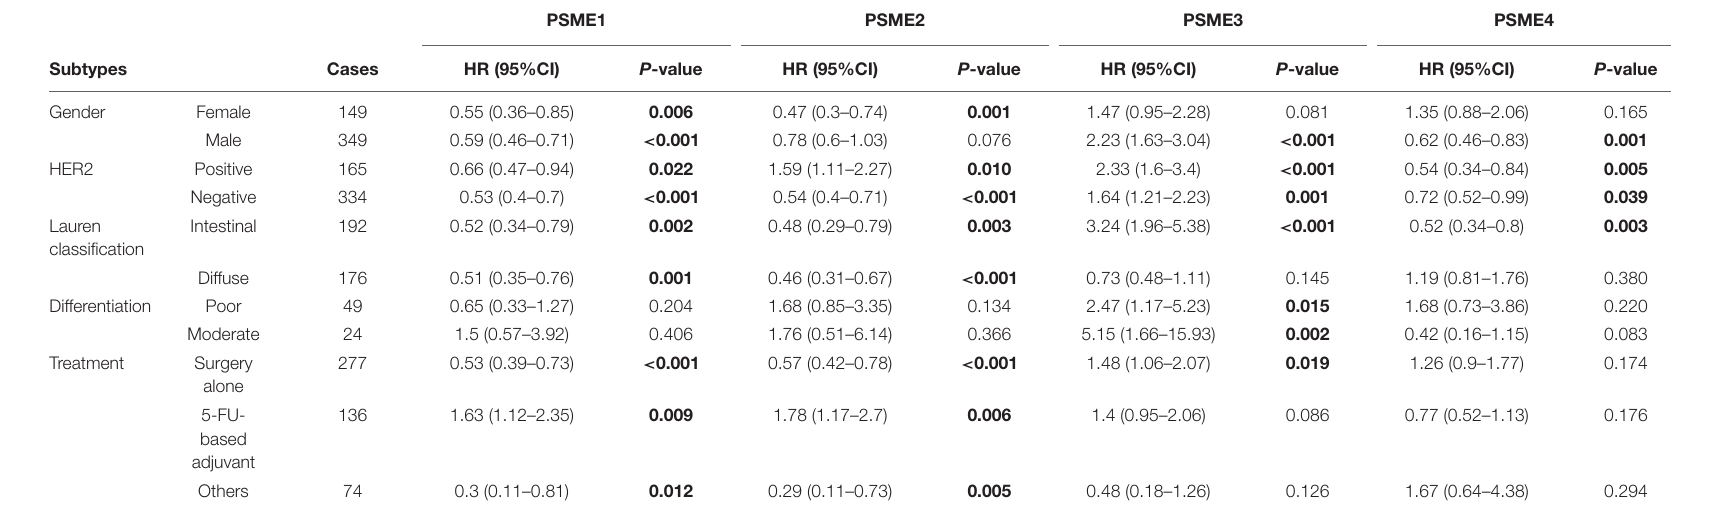
TABLE 3 | The correlation between PSME genes and PPS in different subtypes of GC patients (Kaplan–Meier plotter). PSME1 PSME2 PSME3